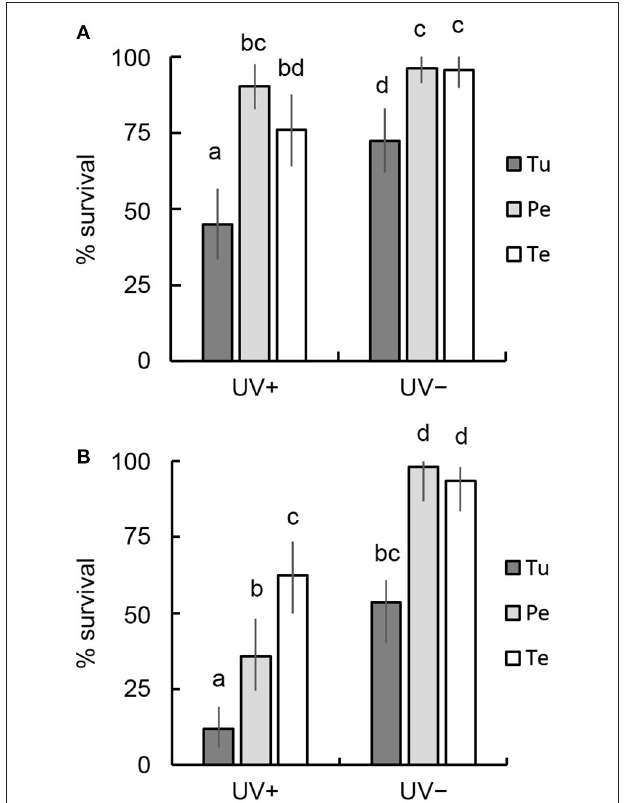
FIGURE 1 | Comparison of the survival rates of adult females fed mites or pollen for 5 days after UVB irradiation. (A) 7.72 kJ m − 2 , (B) 15.44 kJ m − 2 . UV + , irradiated with UVB; UV–, untreated control. Prey and food sources of parental females were T. urticae (Tu), peach pollen (Pe), and tea pollen (Te). The vertical lines on each bar show 95% CI. Different letters indicate statistically significant differences based on pairwise comparisons of proportions (Fisher’s exact test, P <